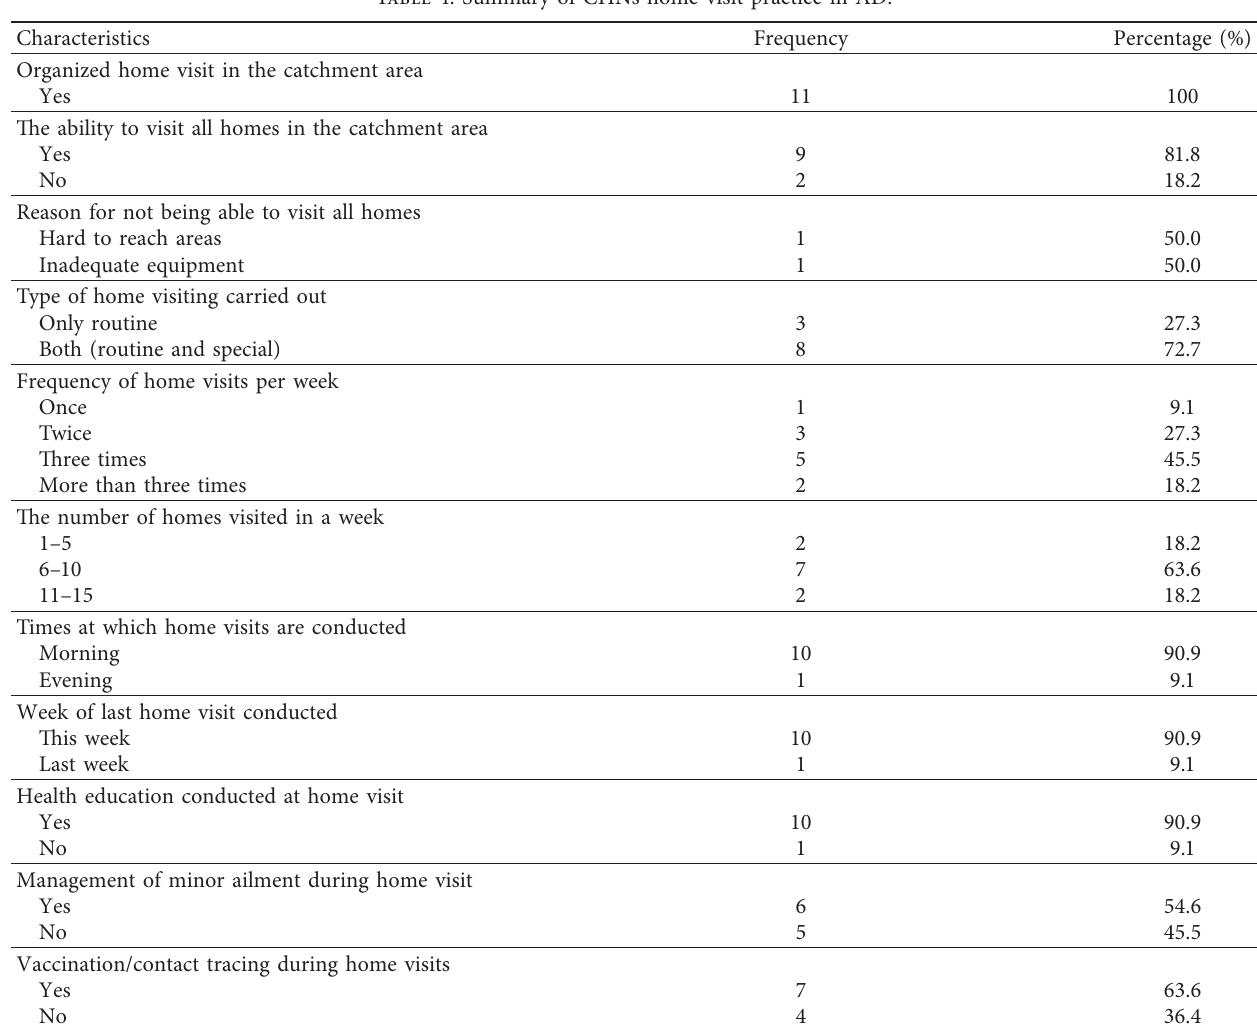
Table 4: Summary of CHNs home visit practice in